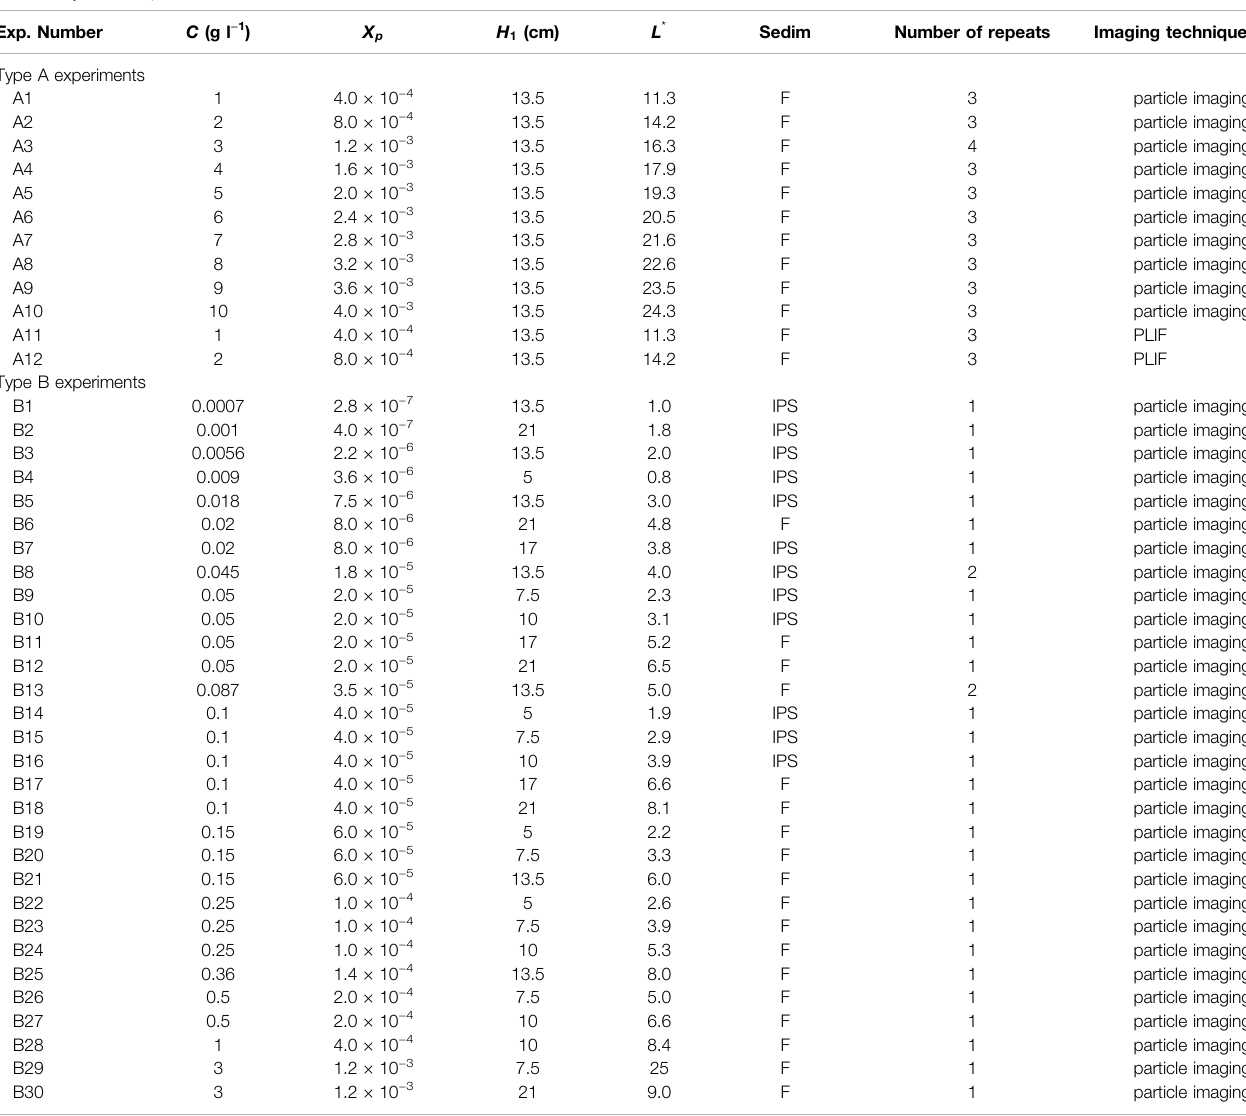
TABLE 2 | List of experiments. Exp.